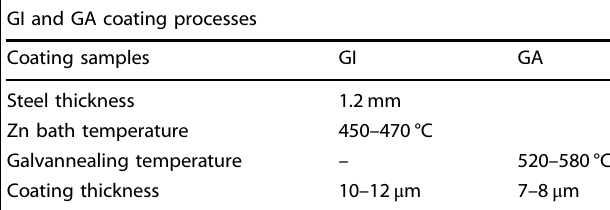
Table 2. Variables for the GI and GA coating processes.